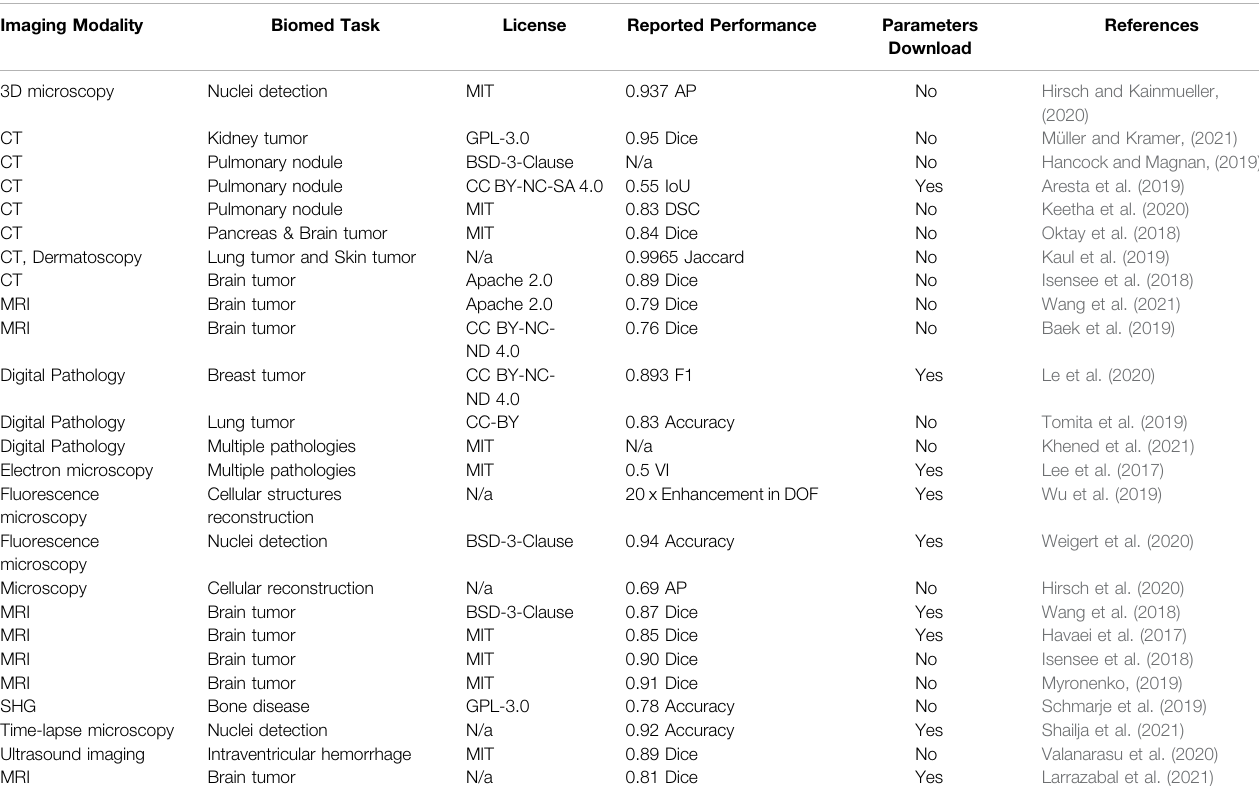
TABLE 2 | Biomedical Image Segmentation Models. Here, CT is computed tomography, DSC is Dice similarity coef fi cient, AP is Average Precision, IoU is Intersection over Union, DOF is Depth of fi eld, AUC is Area under curve, SHG is Second harmonic generation microscopy. Imaging